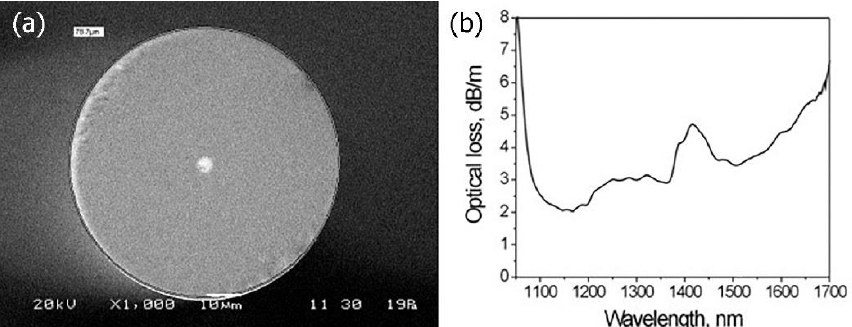
Figure 1. ( a ) Cross section of the Yb-doped composite fiber, ( b ) optical loss spectrum measured in the composite fiber. Reprinted with permission from [19] © The Optical Society.